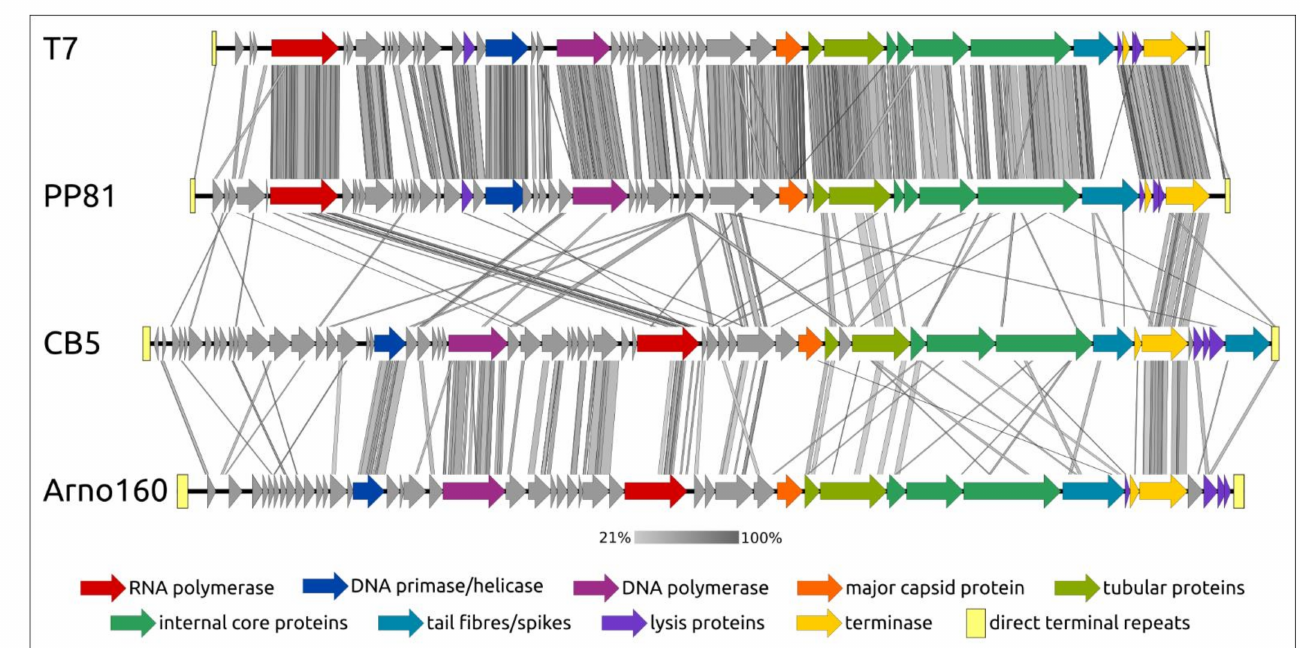
Figure 8. Genome comparison between Autographiviridae phages made with EASYFIG and TBLASTX. T7— Escherichia phage T7 ( Studiervirinae , Teseptimavirus ), PP81— Pectobacterium phage PP81 ( Studiervirinae , Pektosvirus ), CB5— Pectobacterium phage vB_PatP_CB5 ( Corkvirinae , Phimunavirus ), Arno160— Pectobacterium phage Arno160 ( Melnykvirinae , Wanjuvirus ). The percentage of sequence similarity is indicated by the intensity of the grey colour. Vertical blocks between analysed sequences indicate regions with at least 21%